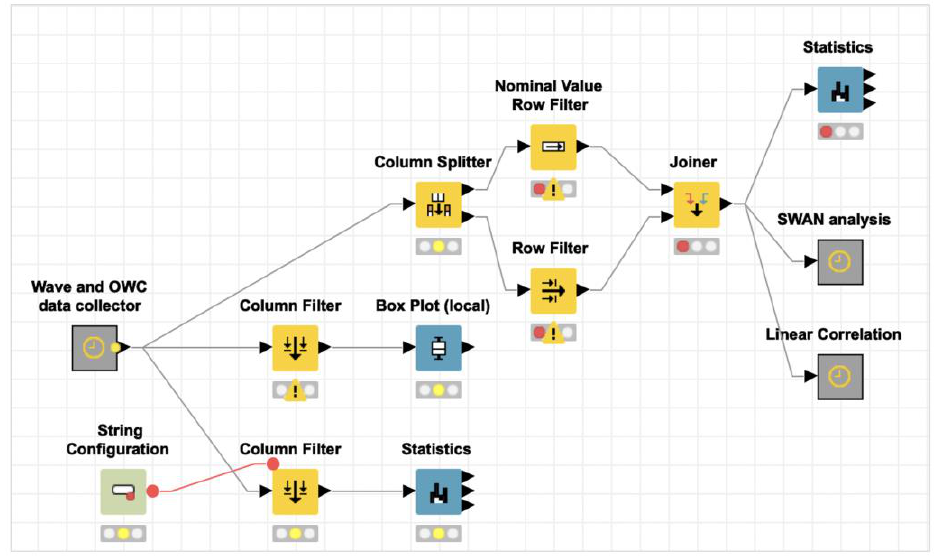
Figure 6. Correlation analysis.